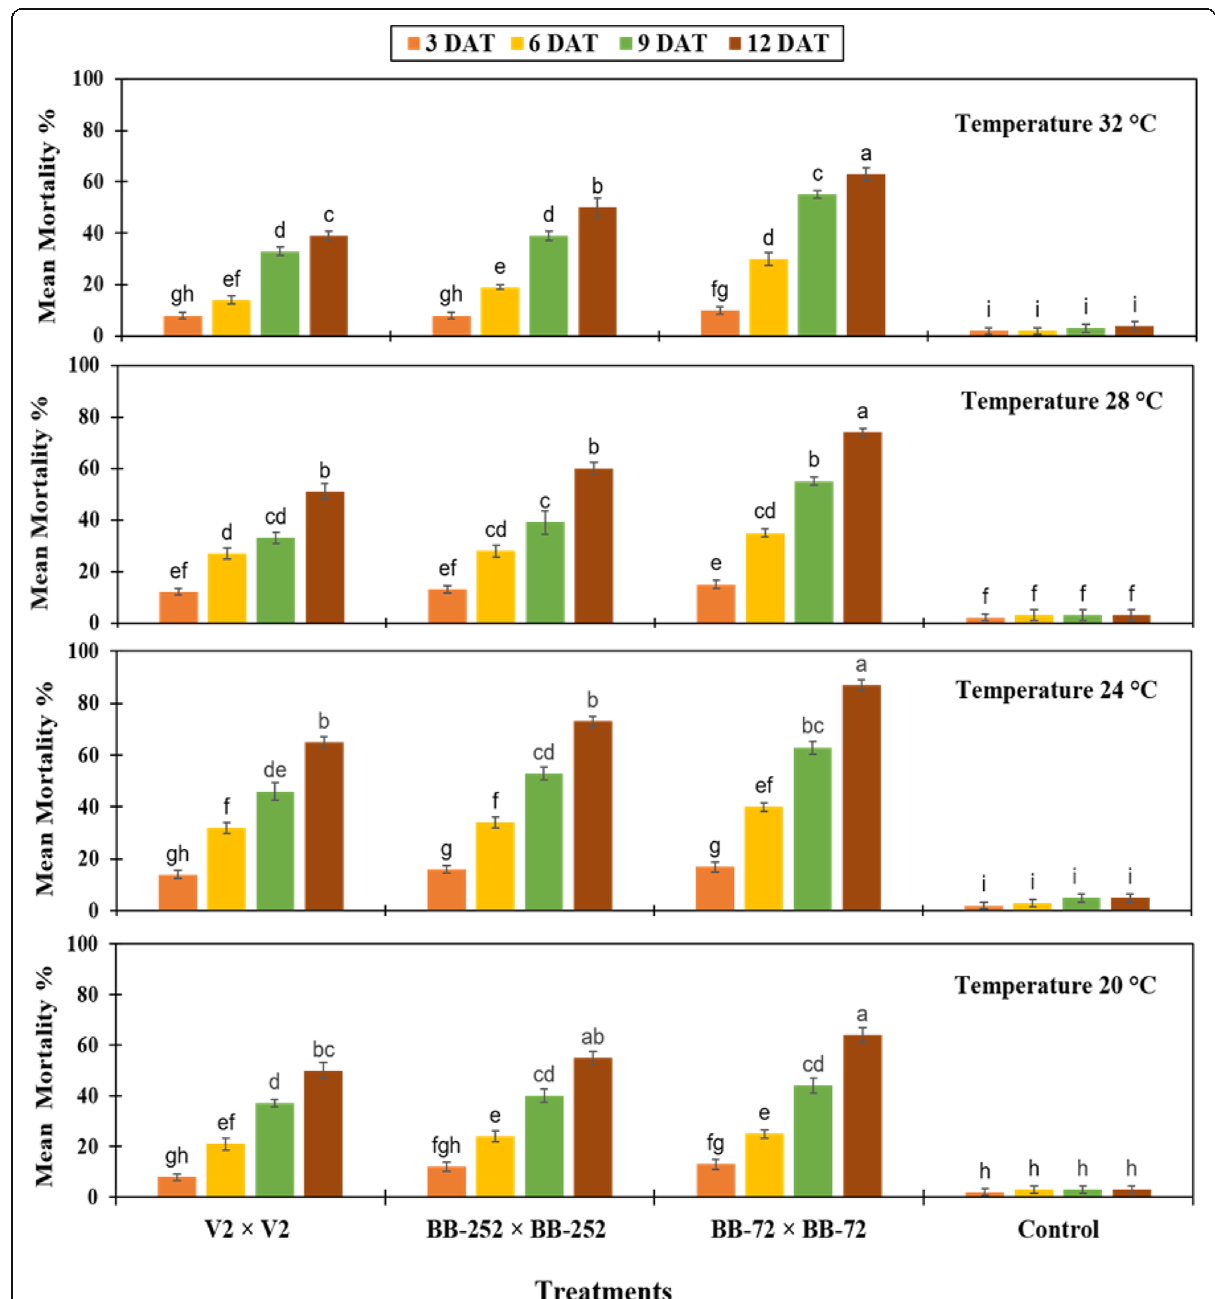
Fig. 3 Mean mortality percentage of Bemisia tabaci recorded at different temperature and time intervals (DAT: days after treatment) for binary combinations (conidia + filtrate) and bioassays carried out with two strains of Beauveria bassiana (BB-72 × BB-72 and BB-252 × BB-252) and one strain of Lecanicillium lecanii (V2 × V2). Columns represent mean percent mortality ± SE ( n = 10). Treatment columns bearing different alphabets are significantly different from other treatments (least significant difference (LSD) test at α =